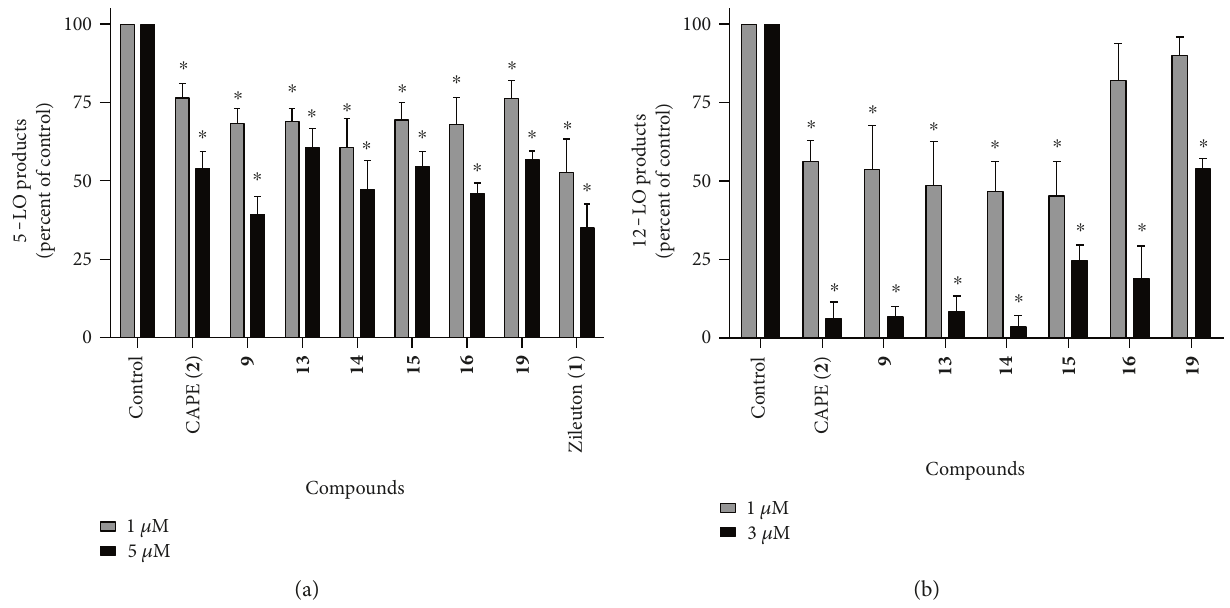
Figure 5: The inhibitory e ff ects of the test compounds of the biosynthesis of 5-LO products in stimulated whole blood (a) and the biosynthesis of 12-lipoxygenase products in platelets (b). (a) Whole blood was incubated in presence of various compounds (1 μ M and 5 μ M) or with their diluent (control, DMSO 0.5%) for 5 min, then stimulated with opsonized zymosan (5 mg/ml) for 30min at 37 ° C. CN (1 :1). Samples were processed for Blood was then centrifuged and plasma was collected and added to 3.5 volumes of MeOH:CH 3 analysis by RP-HPLC for total 5-LO products quanti fi cation. Total 5-LO products measured represent the sum of LTB , its trans isomers, 4 20-COOH and 20-OH-LTB , and 5-hydroxyeicosatetraenoic acid. (b) Platelets were incubated for 5min in presence of test compounds 4 (1 μ M and 3 μ M) then biosynthesis of 12-HETE was initiated with the addition of 10 μ M of calcium ionophore A23187. Reactions were stopped with the addition of two volumes of MeOH:MeCN (1 : 1 v / v ). Samples were processed for analysis by RP-HPLC for 12-hydroxyeicosatetraenoic acid (12-HETE) quanti fi cation. ∗ Di ff erent from control as determined by one-way ANOVA with Dunnett ’ s multiple comparison test ( p < 0 05 ). Data are expressed as means ± SEM of at least 3 independent experiments.